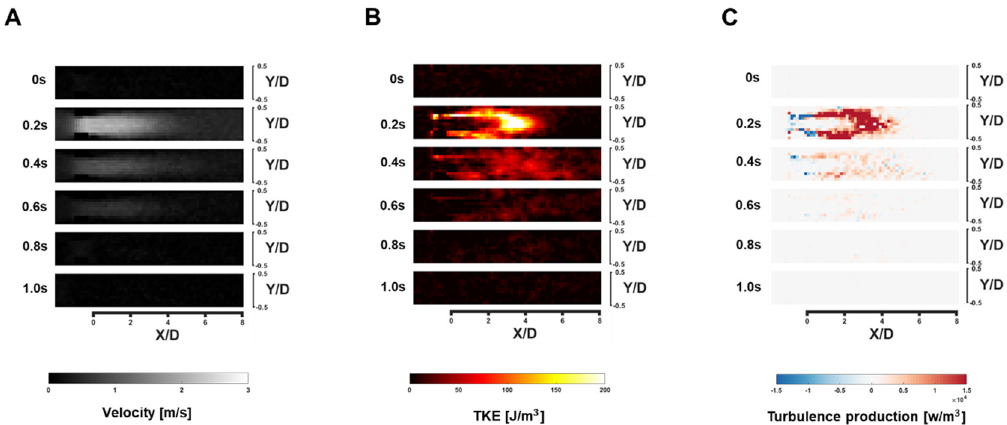
Figure 10. 4D flow MRI measurements of velocity and turbulence under pulsatile flow condition. ( A ) Velocity contours. ( B ) Turbulence kinetic energy con-tours. ( C ) Turbulence production contours.